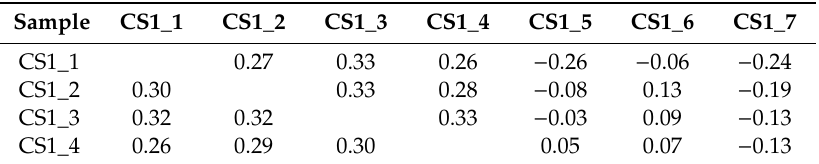
Table 4. Log AR for two-sample comparisons of reference samples (CS1_1–CS1_4) from the coltan case study mine site and two-sample comparisons of samples from other mine sites nearby (CS1_5–CS1_7) and samples from the case study mine site (for details, see